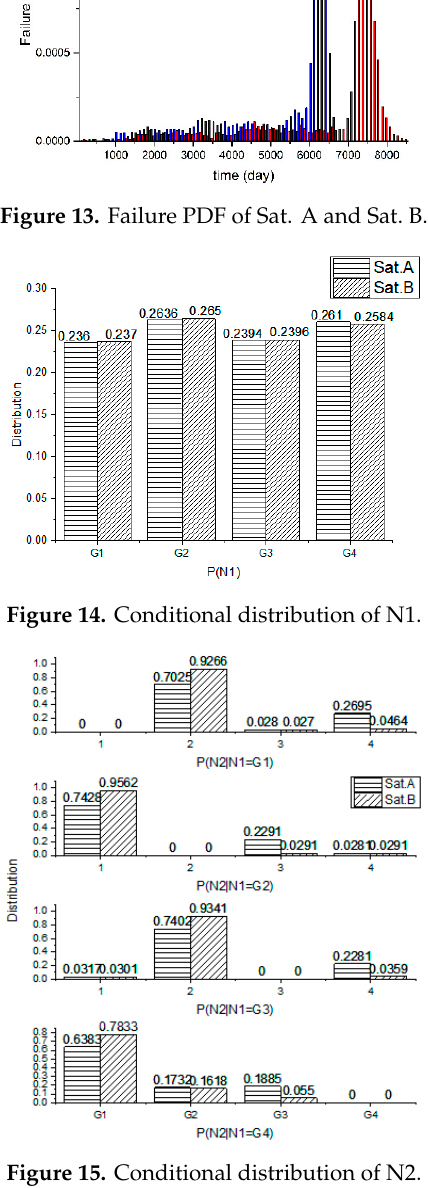
Figure 15. Conditional distribution of N2.